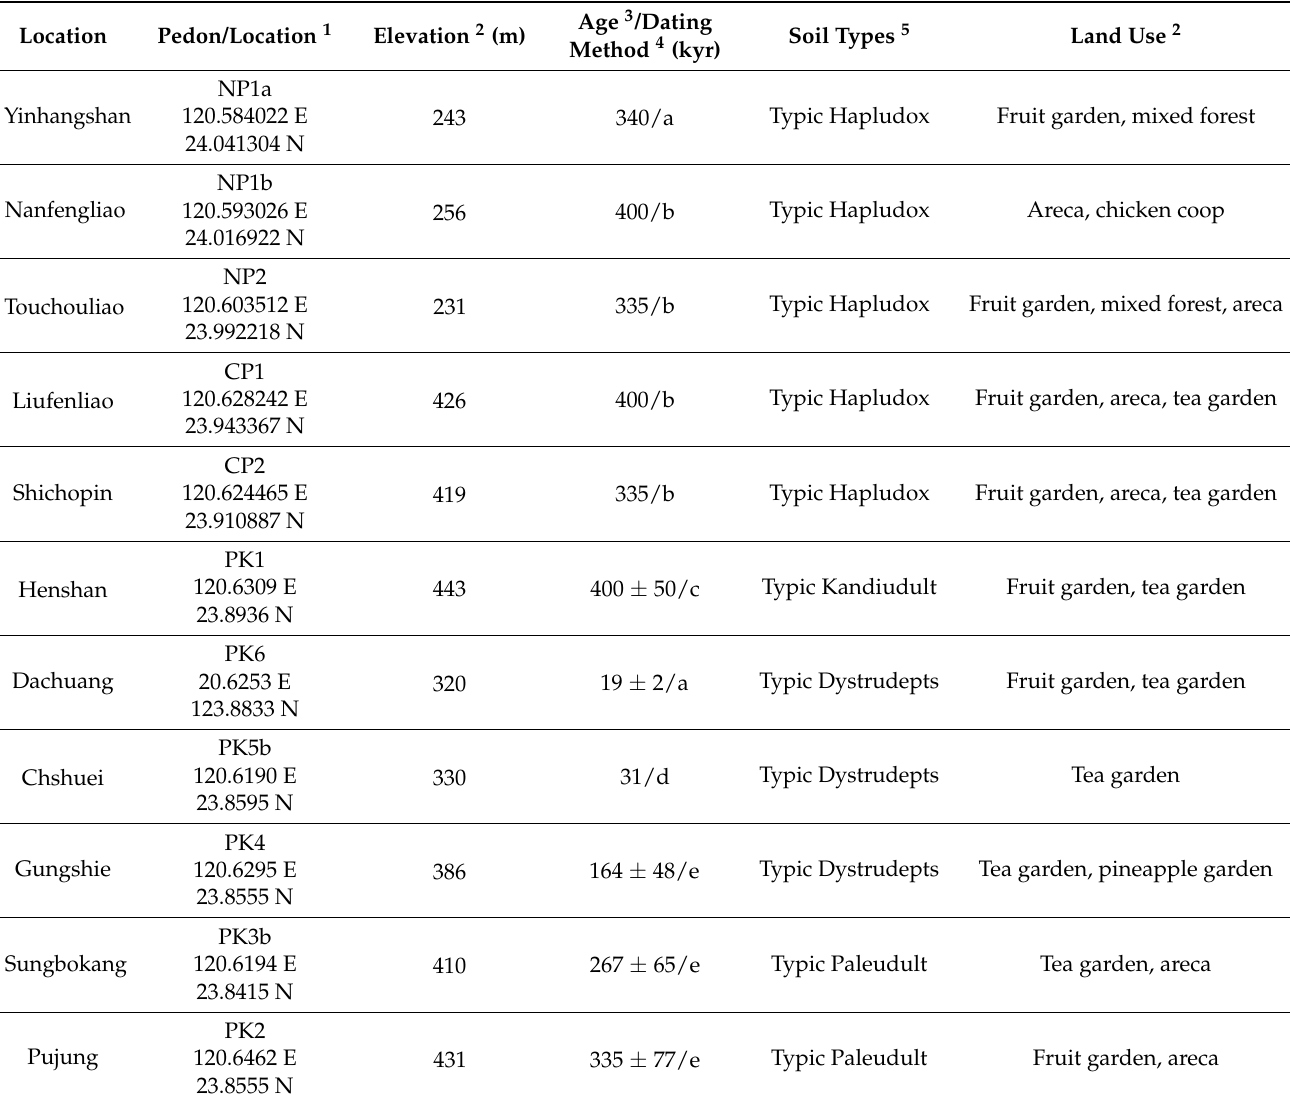
Table 1. Pakua tableland soil type distribution and